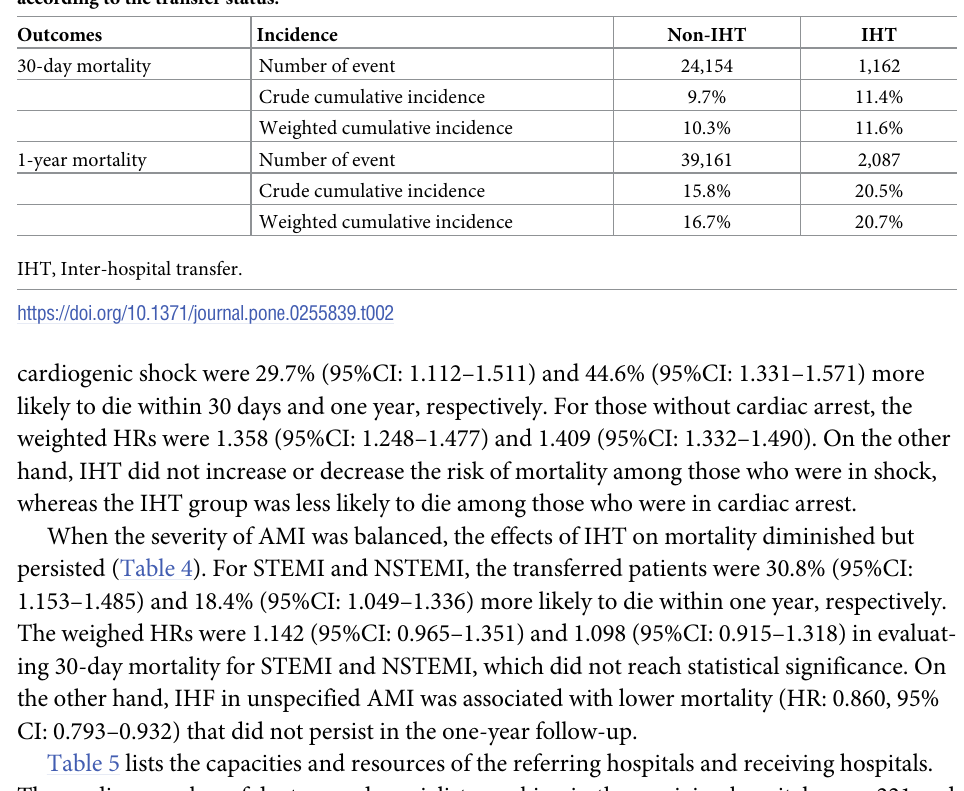
Table 2. Cumulative incidence of the 30-day and one-year mortality in acute myocardial infarction patients according to the transfer status.